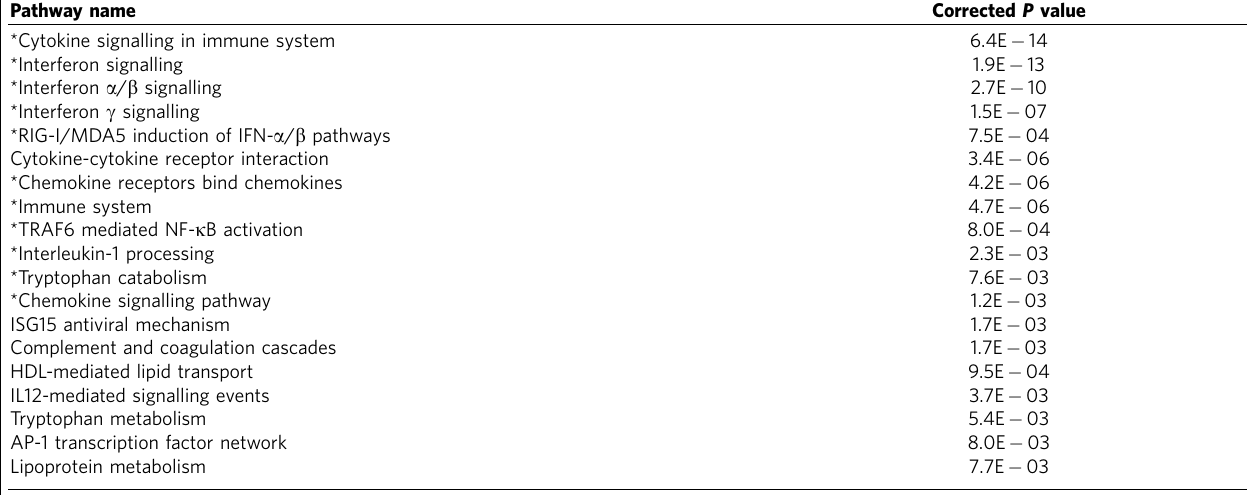
Table 2 | Pathways upregulated in human iPSdMs upon C. trachomatis infection as shown by proteomics. Pathway name